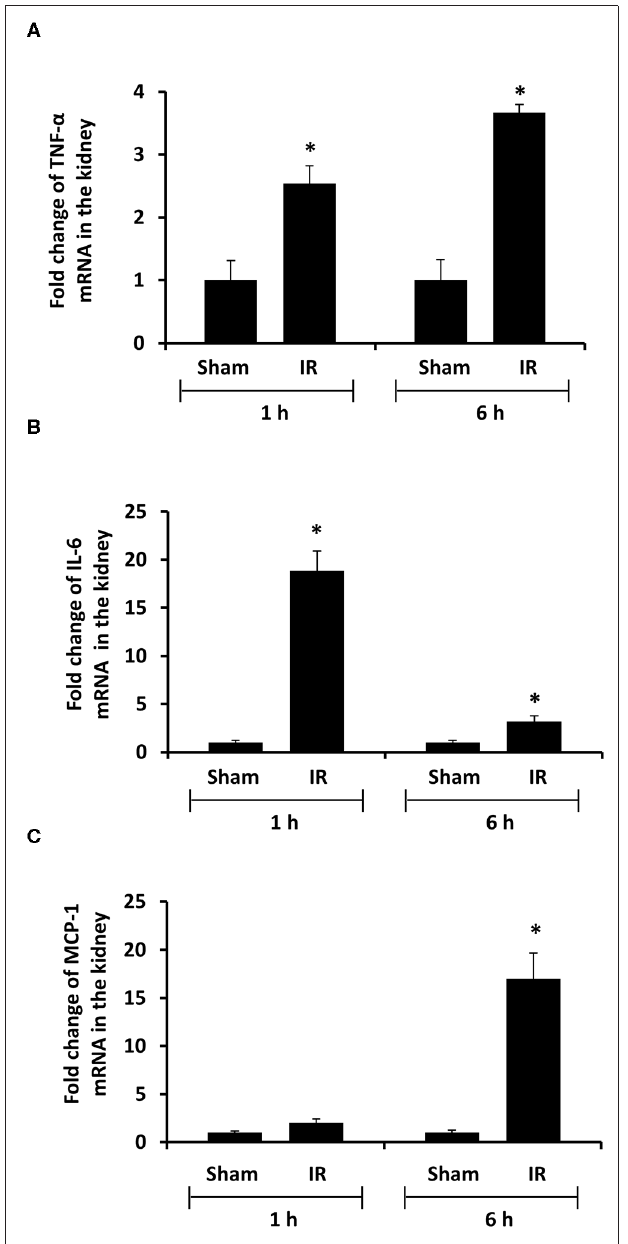
FIGURE 6 | Effect of kidney ischemia-reperfusion on cytokine mRNA expression in the liver. The left kidney of rats was subjected to 45 min ischemia followed by 1 hour (1h) or 6 hours (6h) of reperfusion (IR). As a control, rats were subjected to a sham-operation without inducing ischemia (Sham). The mRNA expression of TNF- α (A) , IL-6 (B) , and MCP-1 (C) was determined in the liver by a real-time PCR analysis. Results are expressed as fold change to the Sham ( n = 5 for each group). * p < 0.05 when compared with the value obtained from the sham-operated group.